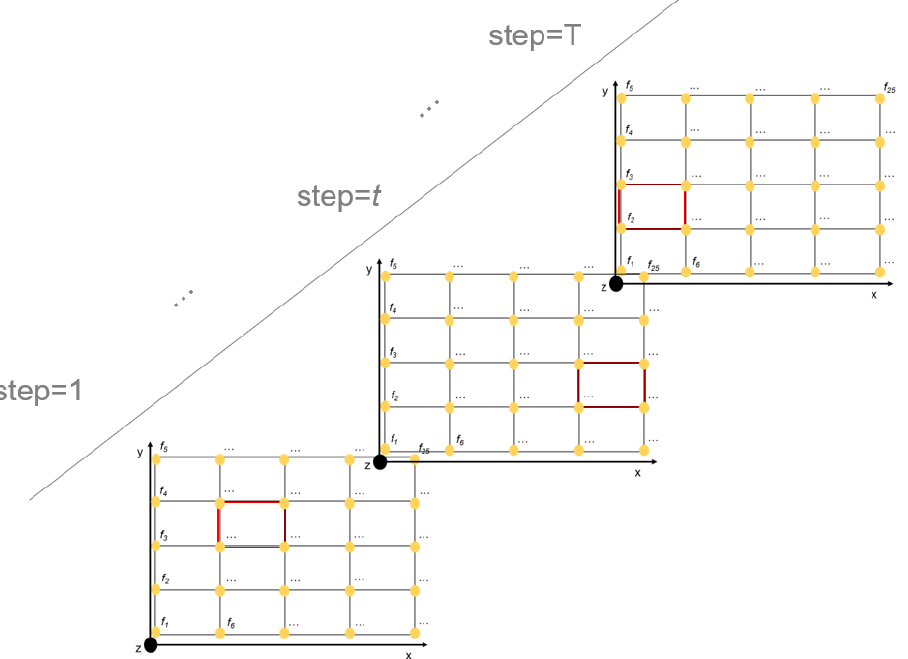
Figure 7. Exemplary determination of the approximative function value z t = f a ( x t , y t ) with a 5 × 5 resolution for multiple timesteps.